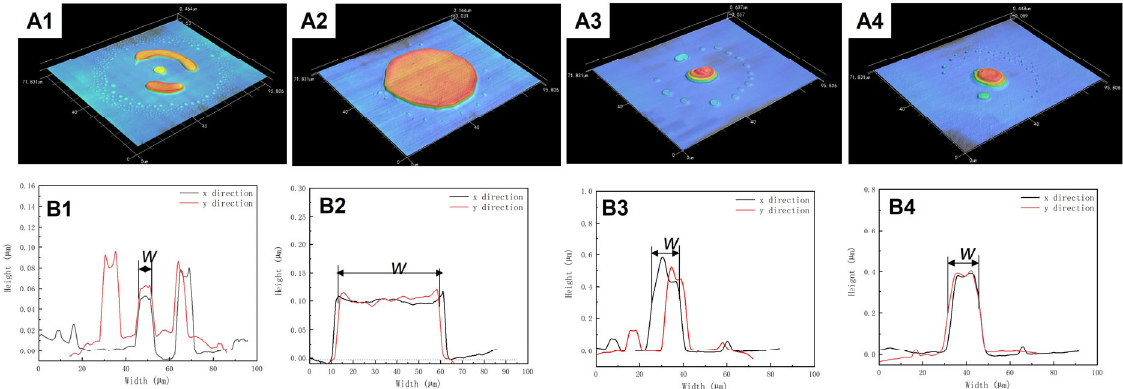
Figure 5. PDMS dots printed on a sapphire substrate with different concentrations of PDMS. ( A1 – A4 ) 3D morphological image of a single PDMS dot, ( B1 – B4 ) PDMS dots’ cross-section profile in the x-direction and y-direction. The concentration of the PDMS from ( A1 – A4 ) was 5 mg/mL, 10 mg/mL, 20 mg/mL, and 30 mg/mL in sequence.